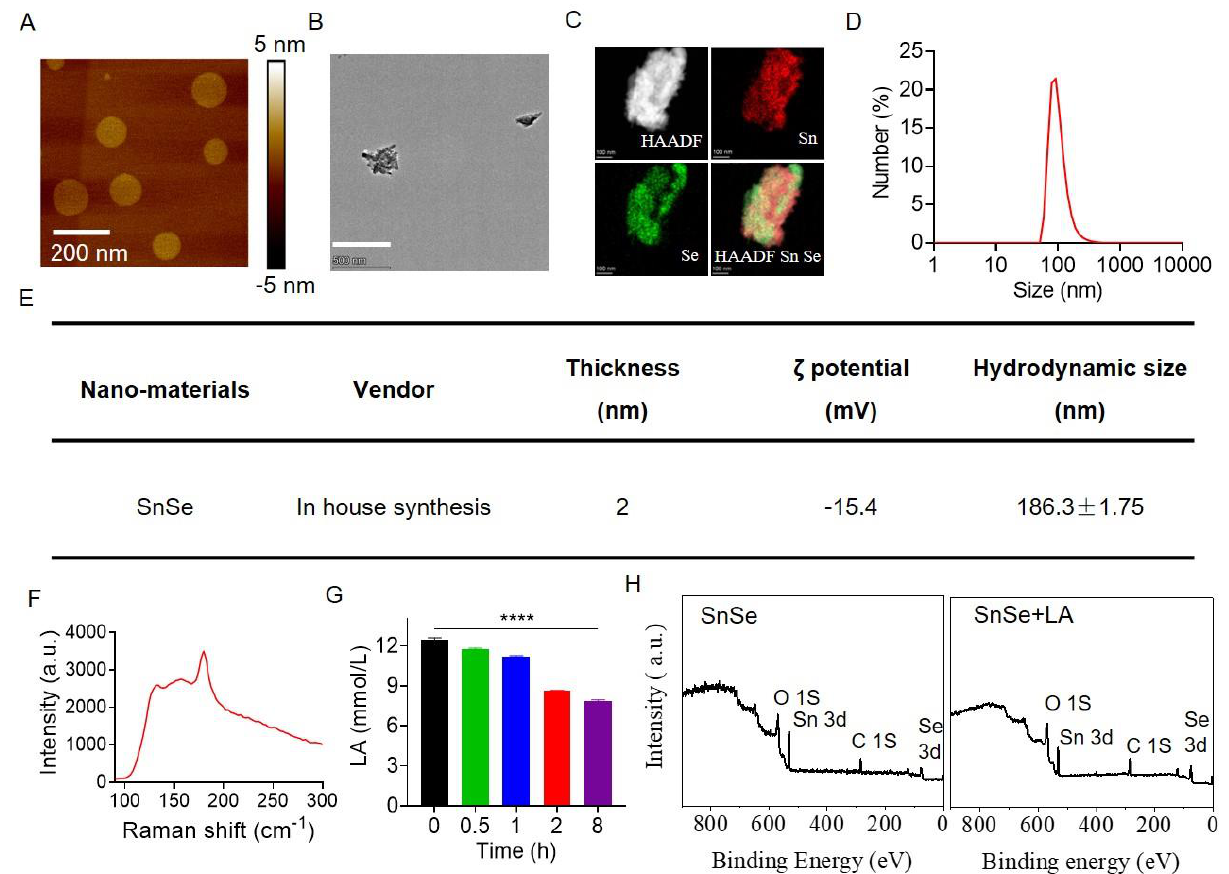
Figure 1. Characterization and functional verification of SnSe NSs. ( A ) AFM image of SnSe NSs. ( B ) TEM images of SnSe NSs. Scale bar: 500 nm. ( C ) Elemental mapping of SnSe NSs. ( D ) The primary size of SnSe NSs measured by Nano Measurer. ( E ) Table showing the material characteristics analyses of SnSe NSs. ( F ) Depicts the Raman shift of the SnSe NSs. ( G ) Evaluation of lactate consumption at different time points after incubation with SnSe NSs. ( H ) Whole XPS patterns of SnSe NSs and SnSe NSs incubated with lactate. Data are means ± SDs. Statistical significance was calculated using one-way ANOVA followed by Tukey’s post-test. p -value: **** p < 0.0001. a.u., arbitrary